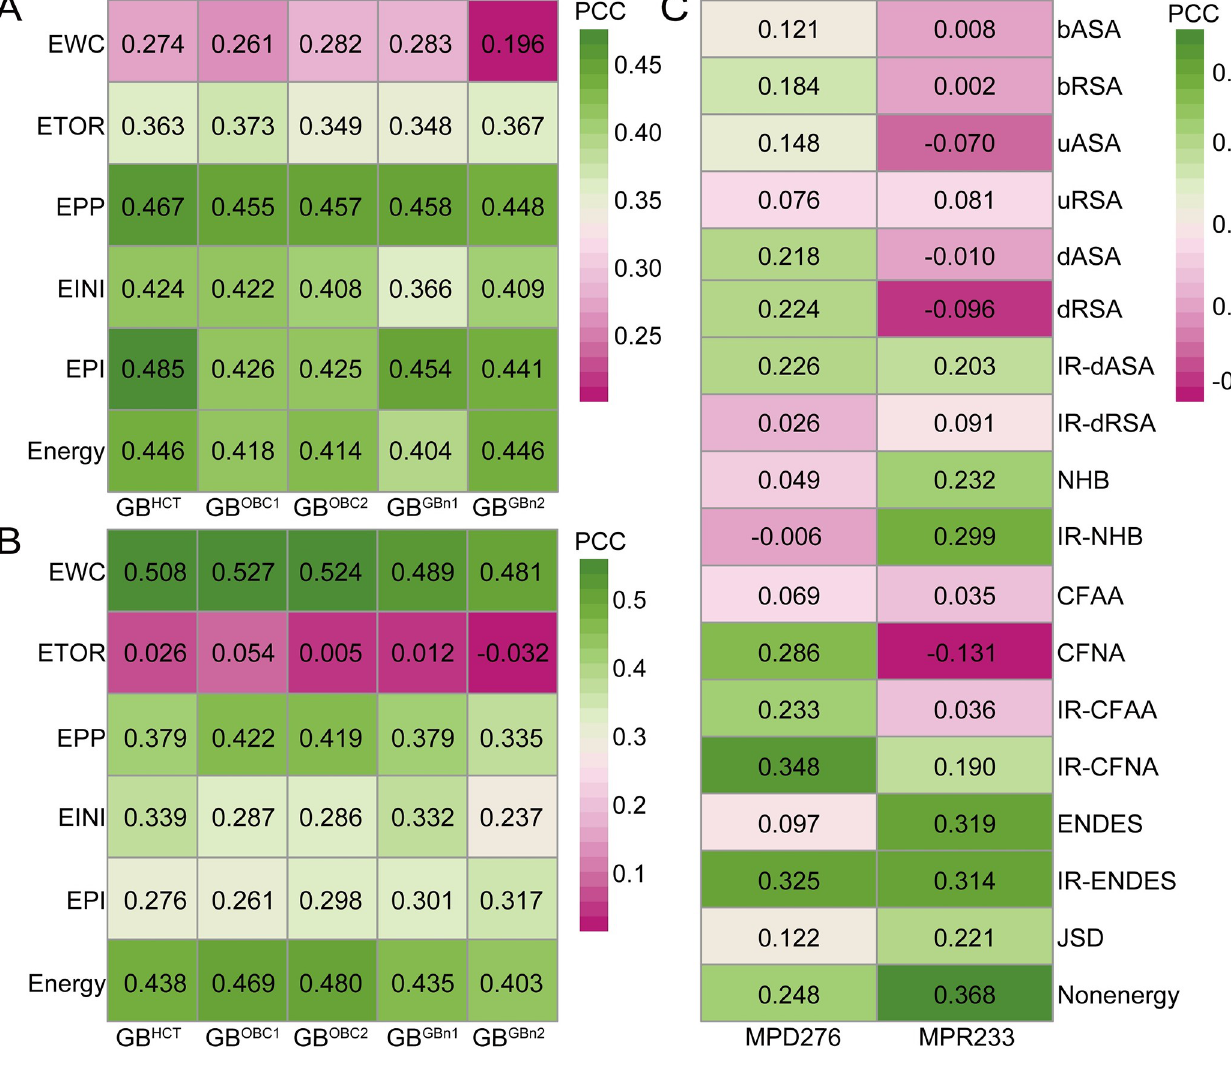
Fig 3. PCC values of individual and integrative feature groups for LOCOV. (A) PCC values of energy feature groups for MPD276. (B) PCC values of energy feature groups for MPR233. (C) PCC values of nonenergy feature groups for MPD276 and MPR233. The last row in each figure shows the performance of integrative feature